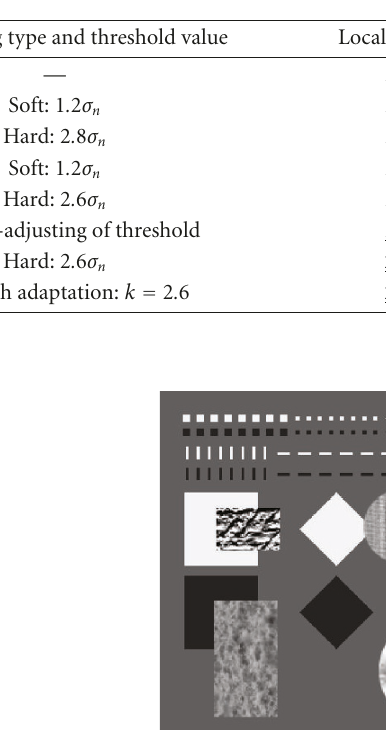
Table 1: PSNR results of processing the test image including texture regions, corrupted by multiplicative noise, σ 2